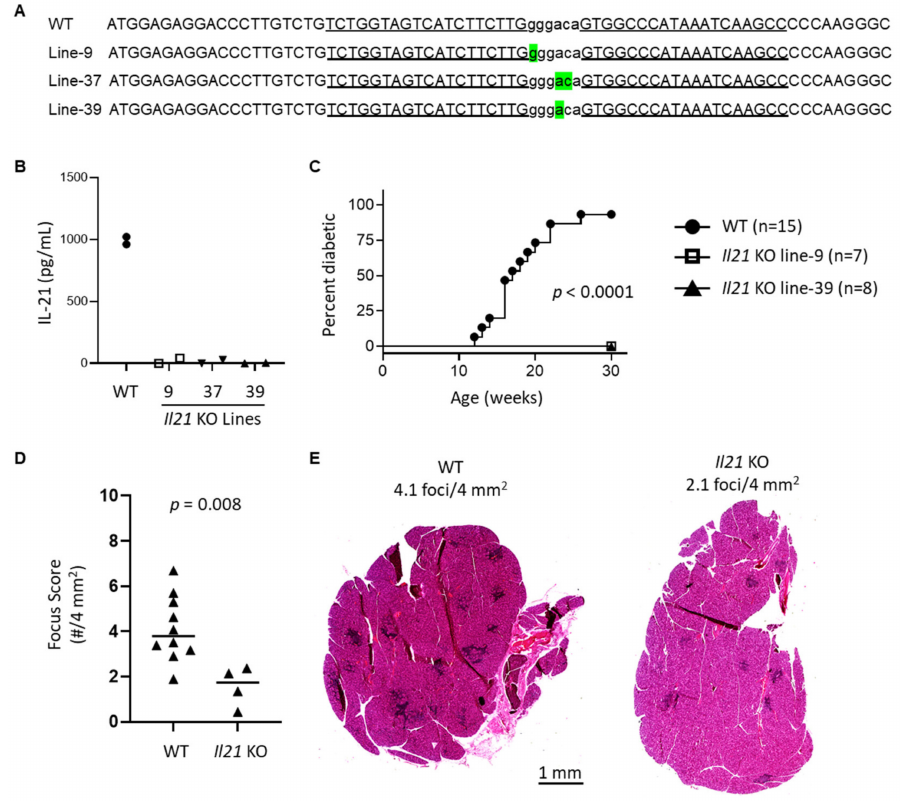
Figure 3. Generation and characterization of new Il21 KO NOD strains. ( A ) ZFN-mediated mutagenesis of the Il21 gene. The partial exon 1 sequence of the WT NOD Il21 is shown at the top. The deleted nucleotides in Il21 mutant lines were determined by DNA sequencing and are highlighted in green below the WT sequence. The ZFN target site is shown in lowercase letters and each of the ZFN binding sequences on the opposite strands is underlined. ( B ) Il21 KO NOD mice do not produce IL-21. Splenocytes isolated from indicated strains were stimulated with soluble anti-CD3, and anti-CD28 in the presence of recombinant IL-6 for 3 days. Tissue culture media was collected and analyzed for IL-21 by ELISA in triplicate. Symbols represent mean of triplicate values for an individual mouse of the indicated genotype/line and are pooled from two independent experiments (1 mouse per group per experiment). ( C ) Il21 KO NOD mice did not develop type 1 diabetes (T1D). Female mice were monitored weekly for T1D development. Diabetes onset was determined by two consecutive positive readings of glycosuria on a urine test strip. ( D ) Quantitation of lacrimal gland inflammation in WT ( n = 10) and Il21 KO ( n = 4, including 1–2 from each KO line). Symbols, lines, and p -value as in Figure 1. ( E ) Representative H&E stained sections of lacrimal glands in ( D ) from WT or Il21 KO NOD mice as indicated. Scale bar = 1